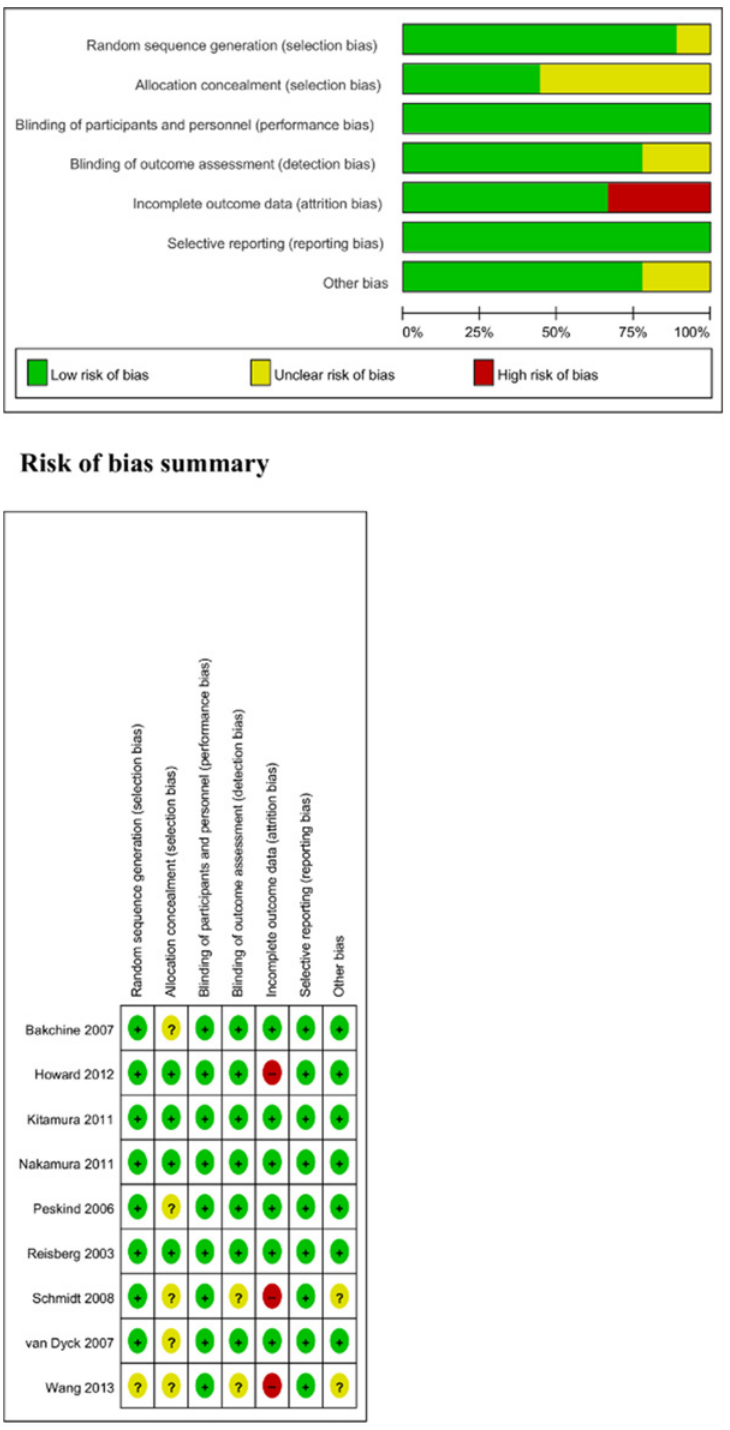
Fig 2. Risk of bias assessment.